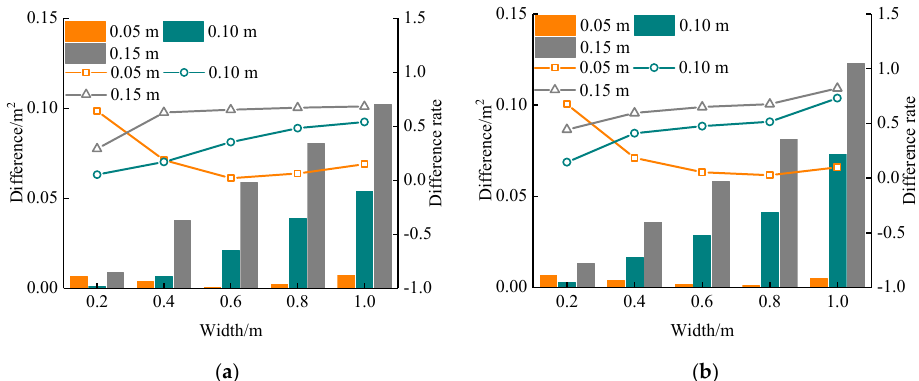
Figure 16. Difference between calculated area and actual area: ( a ) Interface Ⅰ , ( b ) Interface Ⅱ . This figure shows the effect of width and thickness on the difference between calculated area and actual area.